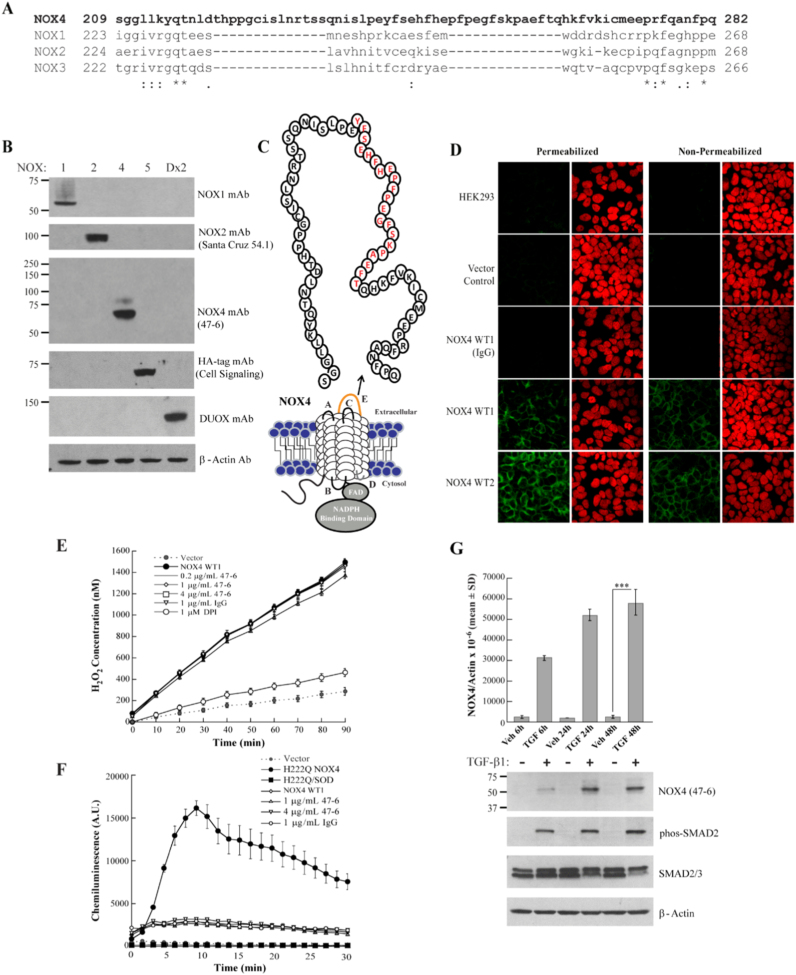
Comprehensive characterization of NOX4 monoclonal antibody 47-6. (A) Multiple sequence alignment performed using Clustal Omega of the E-loop region residues for the NOX1-4 enzymes. NOX5 and DUOX1/2 have short E-loop regions (< 10 amino acids) and therefore were not amenable to sequence alignment. (B) Western analysis carried out with samples positive for NOX1 (64.9 kDa, HEK293 NOX1, NOXA1/NOXO1 stable cell line), NOX2 (~100 kDa, glycosylated form, RPMI 8226 human myeloma cell line), NOX4 (69.7 kDa, HEK293 MycDDK-NOX4 stable cell line WT1), NOX5 (83.1 kDa, KARPAS 299 HA-NOX5 stable cell line), and DUOX2 (Dx2) (175.4 kDa, HEK293 DUOX2/DUOXA2 stable cell line) expression. Twenty micrograms per lane of total protein were loaded. Antibodies used to detect the various NADPH homologues are listed, with details in the Methods section. (C) Schematic illustration of the NOX4 E-loop; the validated recognition sequence is highlighted (red). (D) Confocal microscopy of HEK293 parental, vector control, and MycDDK-NOX4 stable clones 1 (WT1) and 2 (WT2) under permeabilized and non-permeabilized conditions. Cells were incubated with 2 μg/mL 47-6 NOX4 mAb or rabbit IgG (control) prior to secondary antibody staining with Alexa Fluor 488 (Green) and PI nuclei staining (red). (E) H2O2 production by HEK293 NOX4 stable clone 1 versus stable vector control cells measured with the Amplex Red assay. NOX4 overexpressing stable cells were pre-incubated for 30 min at 37 °C with 47-6 mAb, rabbit IgG or DPI before addition to Amplex reagent solution. The assay was monitored every 10 min for 90 min. (F) L-012 Assay measured superoxide generation across superoxide producing stable mutant H222Q NOX4 and WT NOX4 overexpressing stable cells treated with 47-6 mAb or rabbit IgG. SOD (4U) treatment was used to verify superoxide production over 30 min, data was collected every 1.5 min for 30 min. (G) TGF-β1-stimulated NOX4 up-regulation in lung fibroblast cells verified by RNA quantification and immunoblot analysis. Top: Quantitative real-time RT-PCR assay of relative NOX4 expression from 24 h starved lung fibroblasts (CCL-210) treated with vehicle control (Veh) or TGF-β1 (TGF) for 6 h, 24 h, or 48 h, normalized to β-Actin. This data represents the mean and standard deviation from triplicate samples. Bottom: Western analysis of whole cell lysates from lung fibroblasts treated with TGF-β1; 80 μg total protein loaded per lane. TGF-β1 treatment was verified by the detection of phosphorylated SMAD2. ***, p < 0.001. (For interpretation of the references to color in this figure legend, the reader is referred to the web version of this article.)